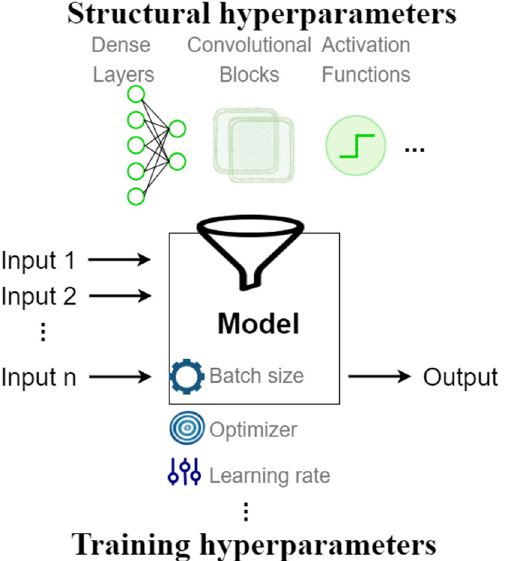
Figure 1. An example of a CNN architecture definition (including hyperparameters).